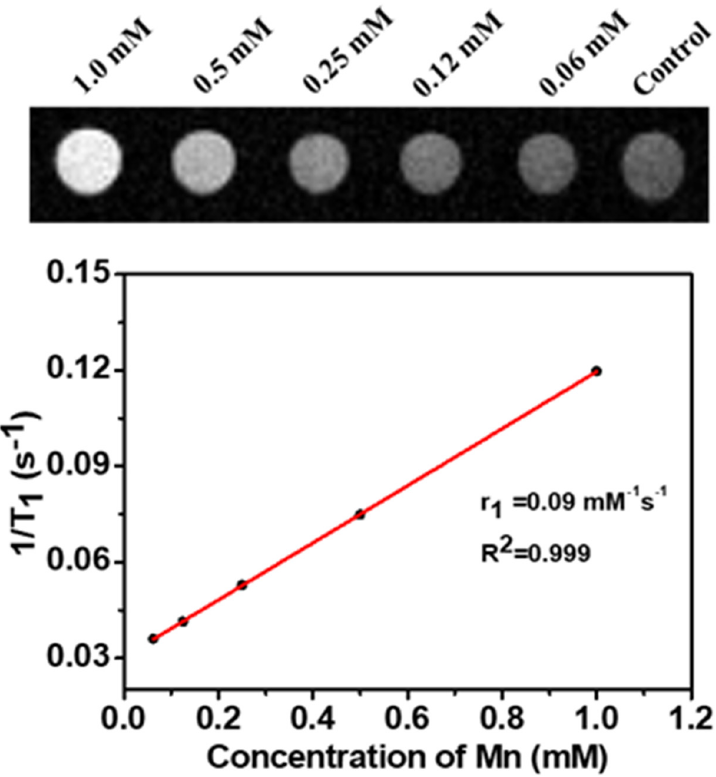
0.09 mM − 1 s − 1 (Figure 8).